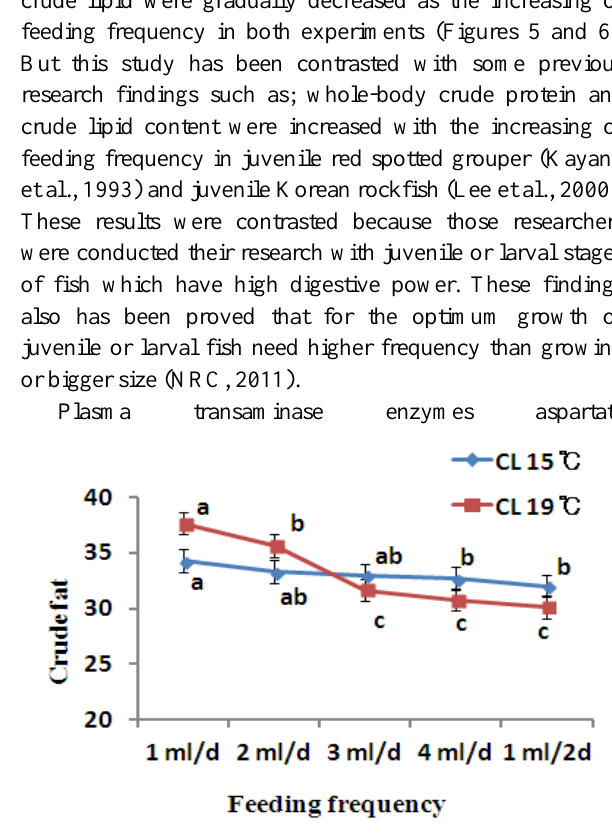
Figure 4. Glutamic oxaloacetic transaminase of rockfish with different feeding frequencies at 15°C and 19°C.